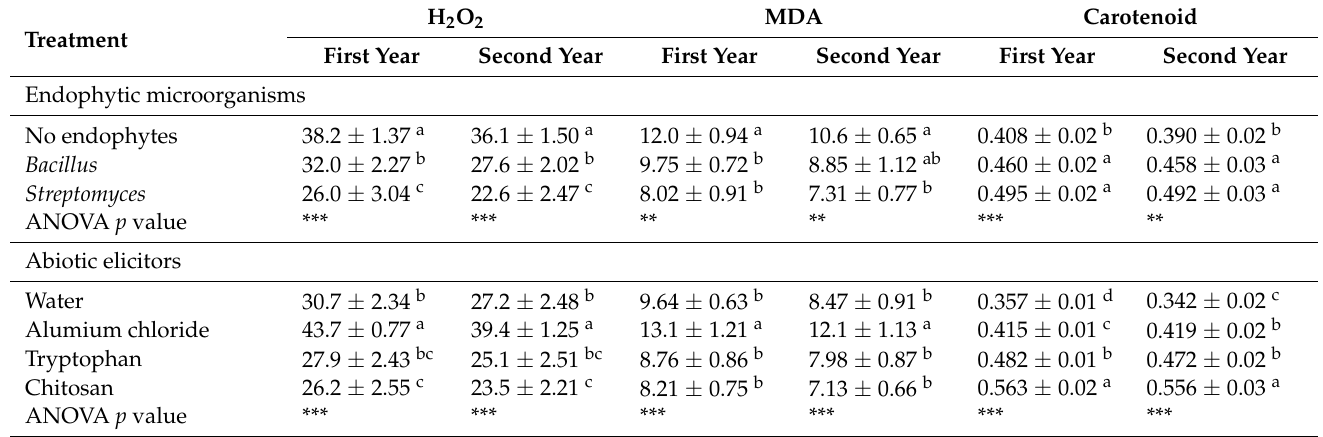
Table 3. Effect of endophytic microorganisms and abiotic elicitors on hydrogen peroxide (H 2 O 2